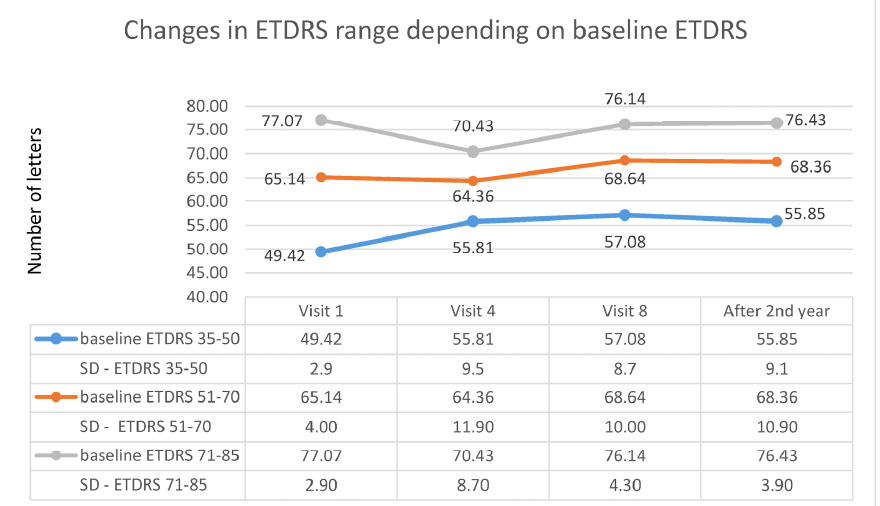
Figure 6. Changes in best corrected visual acuity in the ETDRS during individual follow-up visits in groups based on the initial visual acuity—data for Ranibizumab.